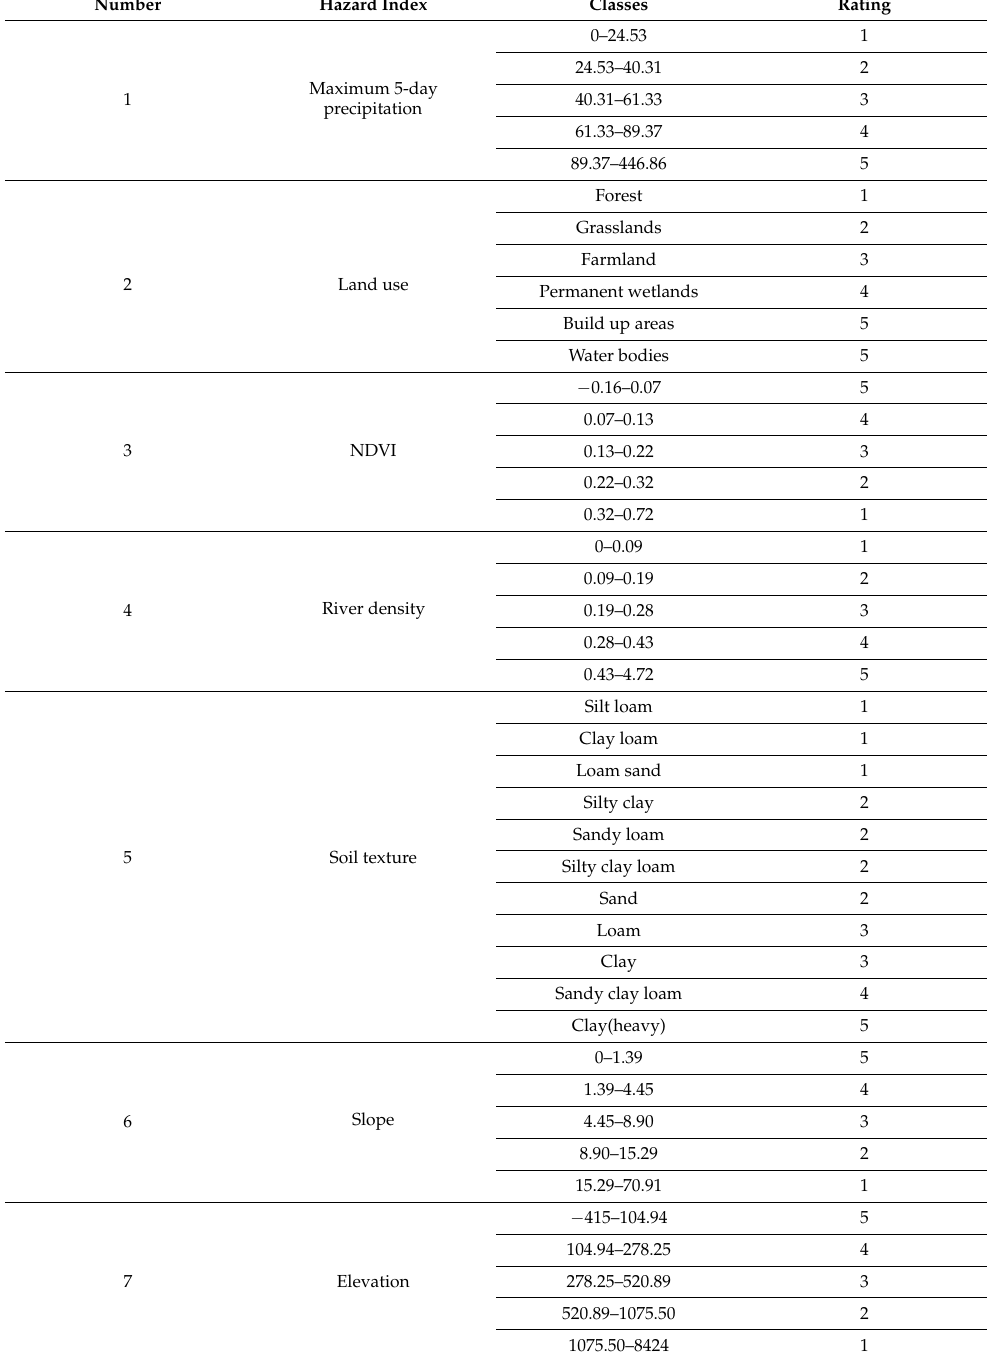
Table 2. Classes of flood hazard factors and their